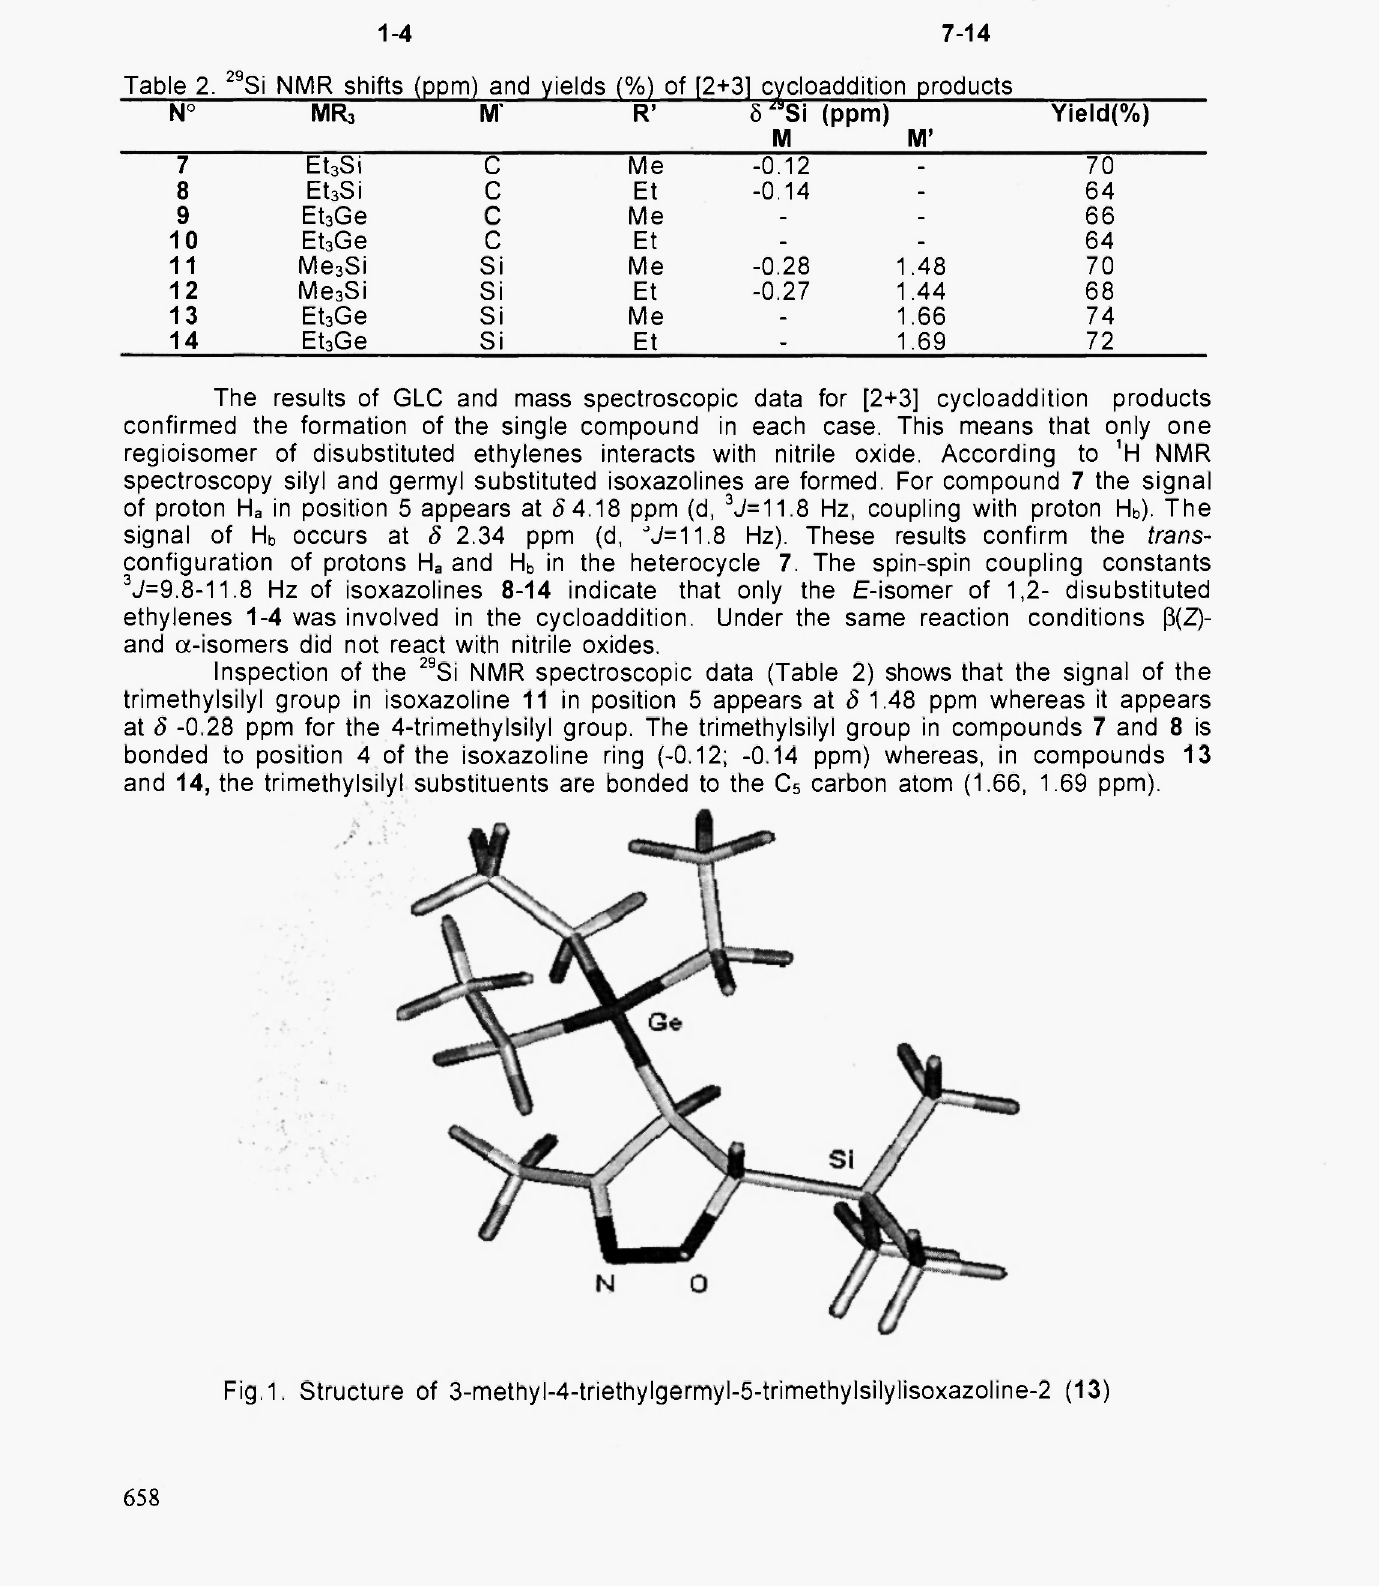
Table 2. 29 Si NMR shifts (ppm) and yields (%) of [2+3] cycloaddition products